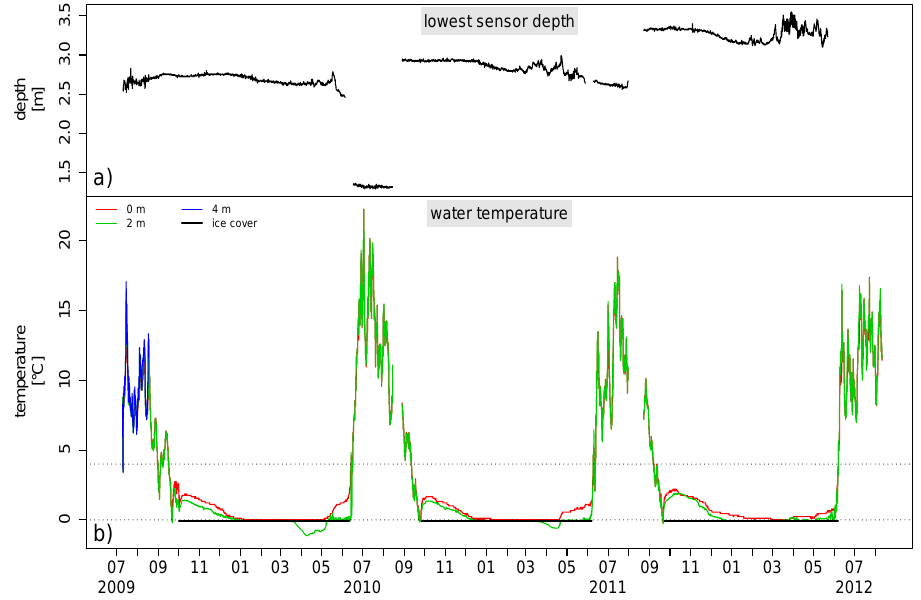
Figure A7. Hourly lake temperatures and lowest sensor depth (indicating water level changes) for Sa_Lake_3, from July 2009 to August 2012. Thick black lines indicate ice-covered